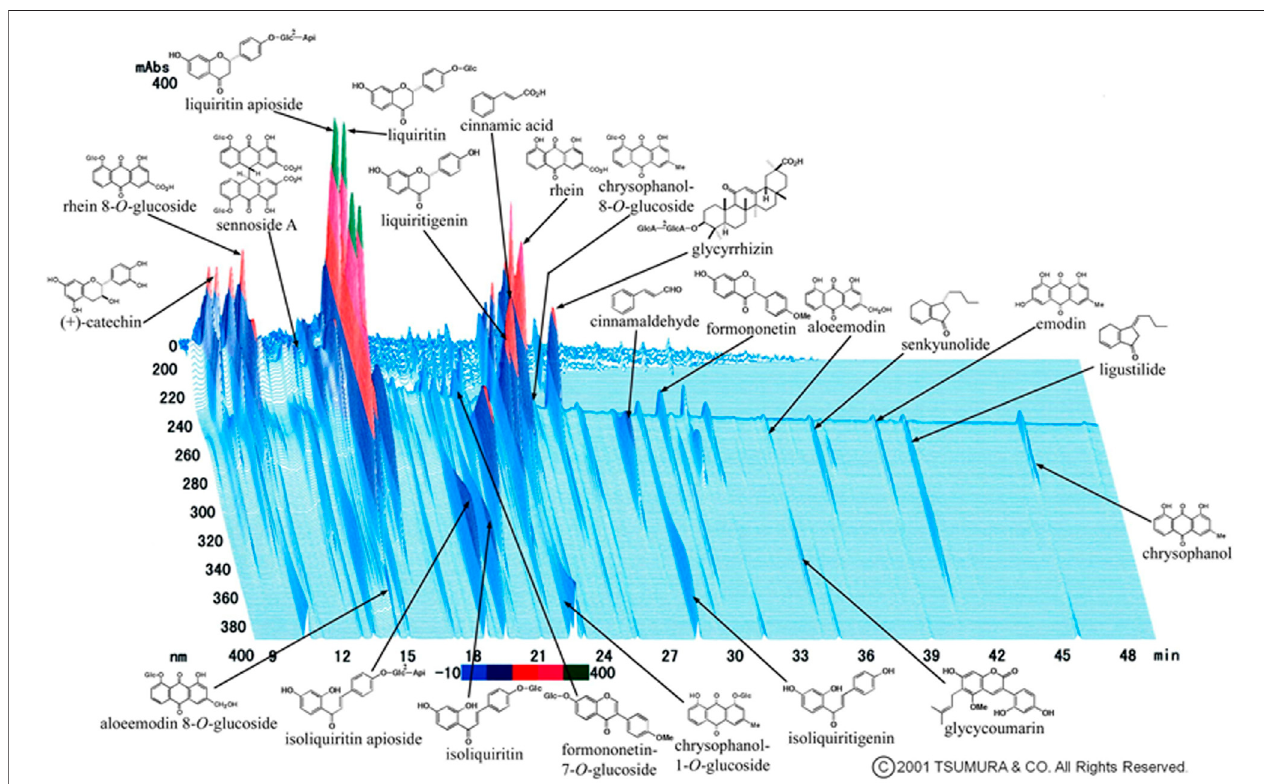
FIGURE 1 | Three-dimensional high-performance liquid chromatography pro fi le of jidabokuippo. Nuphar japonica DC. contains major ingredients: nupharidine, deoxynupharidine, nupharamine, and nupharin. Quercus acutissima Carruth. contains quercitrin, scopoline, fraxin, and tannic acid. Ligusticum of fi cinale (Makino) Kitag. contains cnidilide, neocnidilide, ligustilide*, senkyunolide*, butylphthalide, butylidenephthalide, pregnenolone, vanillin, coniferyl ferulate, ferulic acid, and scopoletin. Neolitsea cassia (L.) Kosterm. contains cinnamaldehyde*, cinnamyl acetate, phenylpropyl acetate, cinnamic acid*, and salicylaldehyde. Syzygium aromaticum (L.) Merr. and L.M.Perry contains acetyleugenol, chavicol, caryophyllene, humulene, caryophylla, eugenocide, eugeniin, higenamine, rhamnetin, and kaempferol. Rheum palmatum L. contains sennoside A* – F, rhein*, aloe emodin*, emodin*, chrysophanol*, naphthalene, catechin*, epicatechin, and cinnamic acid*. Glycyrrhiza glabra L. contains glycyrrhizin*, glabric acid, liquiritin*, liquiritin apioside*, liquiritigenin*, isoliquiritin*, licoricidin, licoricone, lico fl avone, formononetin*, glycerol, and glycycoumarin*.*Shown in Panel 1).